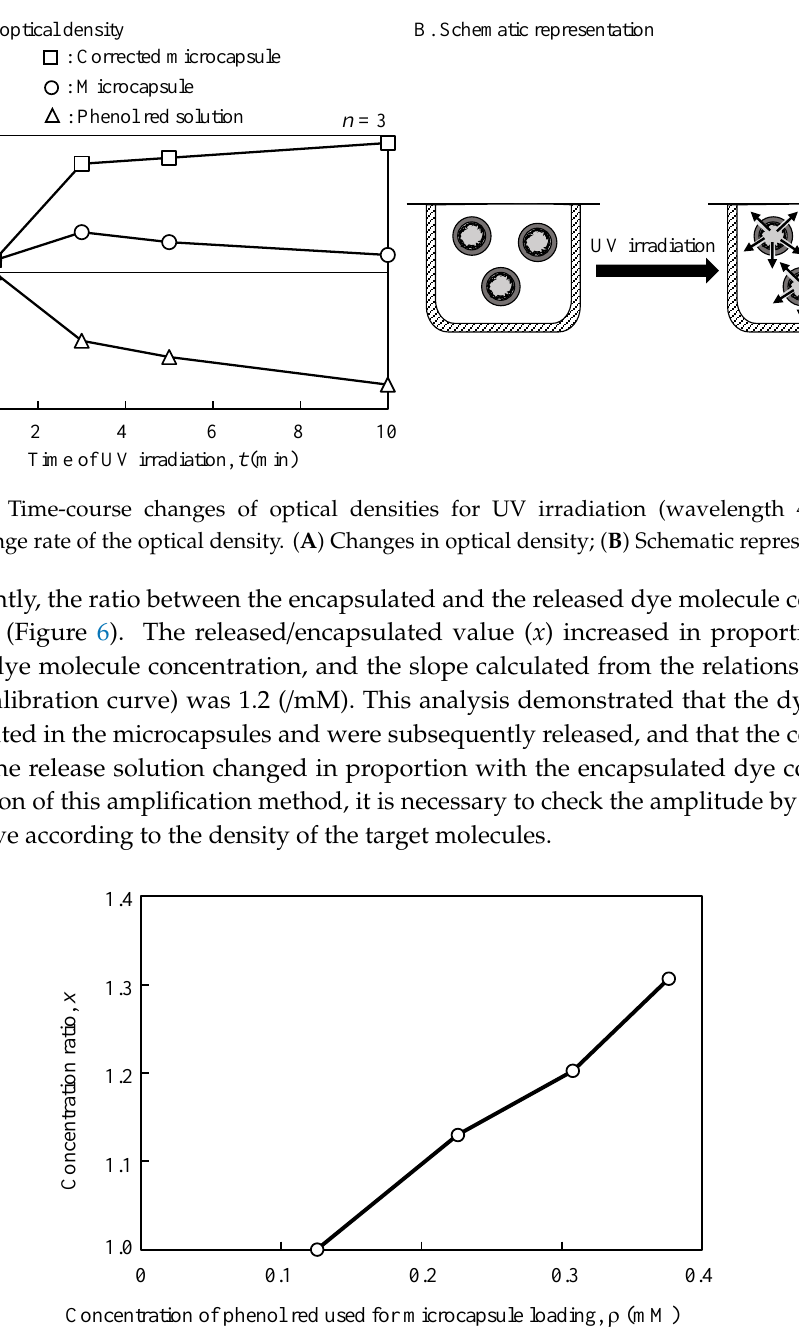
Figure 6. Comparison between the concentration ratio for each phenol red solution loaded into the microcapsules.